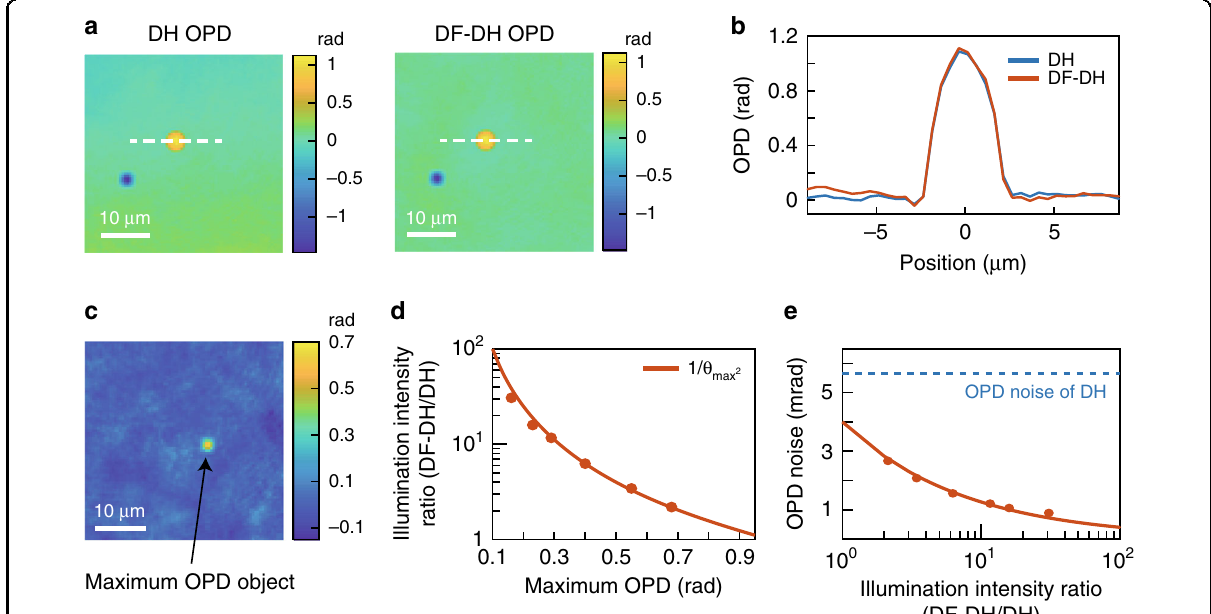
Fig. 2 Experimental validation of DF-DH. a OPD images measured by DH (left) and DF-DH (right). b Cross-sectional pro fi les along the white dotted lines in ( a ). The blue and orange curves represent the results obtained by DH and DF-DH, respectively. c OPD image measured by DF-DH without the sample. An arti fi cial object (indicated by the arrow) with the maximum OPD in the FOV (0.68 rad) is generated with the SLM. The area is used for the sensitivity evaluation. d Illumination intensity ratio of DF-DH and DH versus the maximum OPD value in the FOV. The data show good agreement with the theoretical curve (solid line). e OPD noise (standard deviation of temporal OPD) versus illumination intensity ratio of DF-DH and DH. The blue dotted line indicates the OPD noise of DH and is shown as a reference. The data show good agreement with the theoretical curve (solid line) described in Supplementary Information